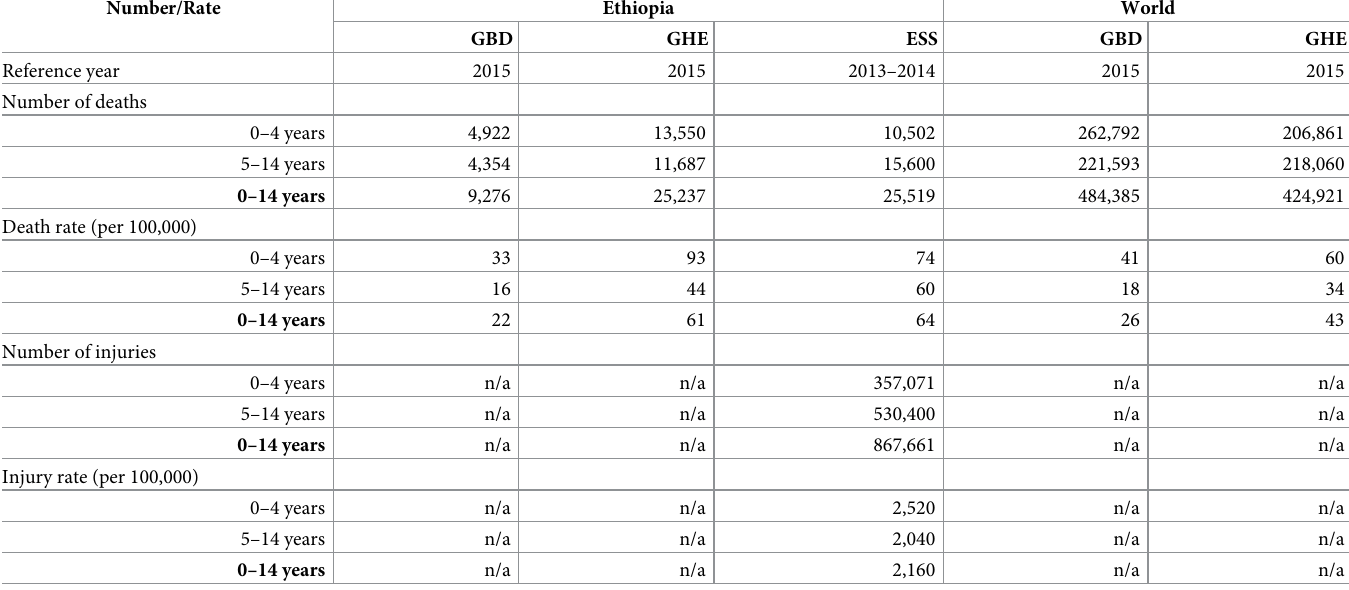
Table 1. Number and rate of mortality due to injuries by age group in Ethiopia and the world from Global Burden of Disease (GBD) 2016, Global Health Estimates (GHE) 2017, and Ethiopian Socioeconomic Survey (ESS) 2013–2014. Number/Rate Ethiopia World GBD GHE ESS GBD